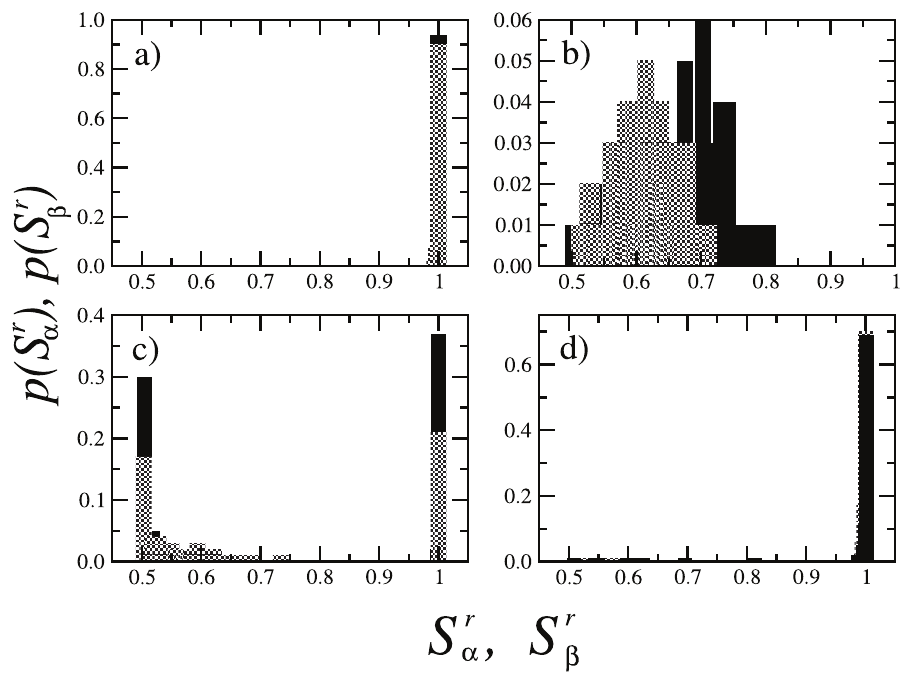
Figure 7. Probability distributions p ( S r ) and p ( S r ) , V r , of normalized domain sizes for both populations a (black bars) and b (grey a b bars), calculated over 100 realizations of initial conditions, with fixed intensity B ~ 0 : 05 , F ~ 10 , and for different values of the number of options q . (a) q ~ 10 (phase I); (b) q ~ 70 (phase IV); (c) q ~ 90 (localized ordered states); (d) q ~ 115 (phase I).